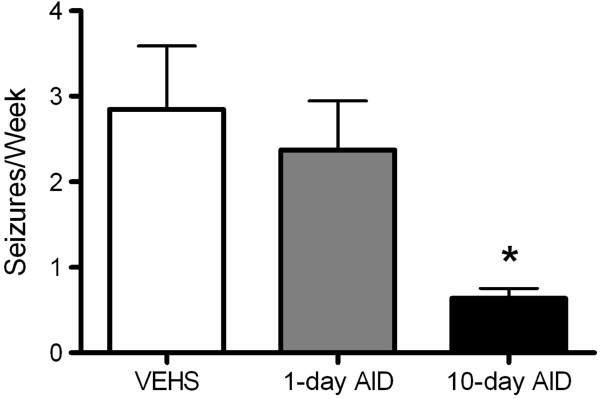
Protracted anti-inflammatory drug treatment reduced the frequency of spontaneous recurrent seizures (SRS) among epileptic animals. Bar graphs represent the average number of seizures observed. Over 3 weeks of continuous video and EEG monitoring, vehicle-treated animals (VEHS) presented an average of 2.9 ± 0.6 seizures per week, while those treated with a single injection of anti-inflammatory drug (AID) did not show significant reduction in seizure frequency and exhibited an average of 2.5 ± 0.4 seizures per week (P >0.5). Animals treated with daily injections of AID for 10 consecutive days showed a marked decrease in SRS frequency (*P <0.05 10 days of drug treatment vs. two other groups, n = 8).